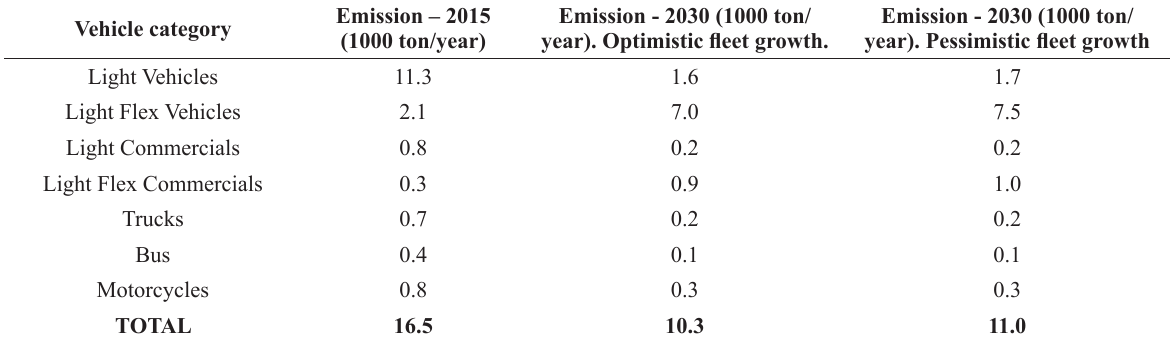
Total emission values of THC, associated with the vehicular activity in the MRPA according to the pessimistic and optimistic scenarios of the fleet for the years 2015 and 2030.